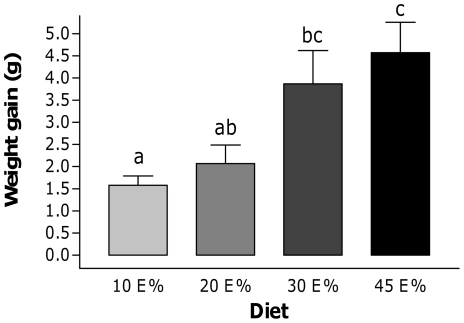
Body weight gain and blood glucose levels.Body weight gain of C57BL/6J mice fed a 10E%, 20E%, 30E% or 45E% fat diet for four weeks. The data are given as means ± SE. a, b, c: bars with superscripts without a common letter differ, p<0.05.